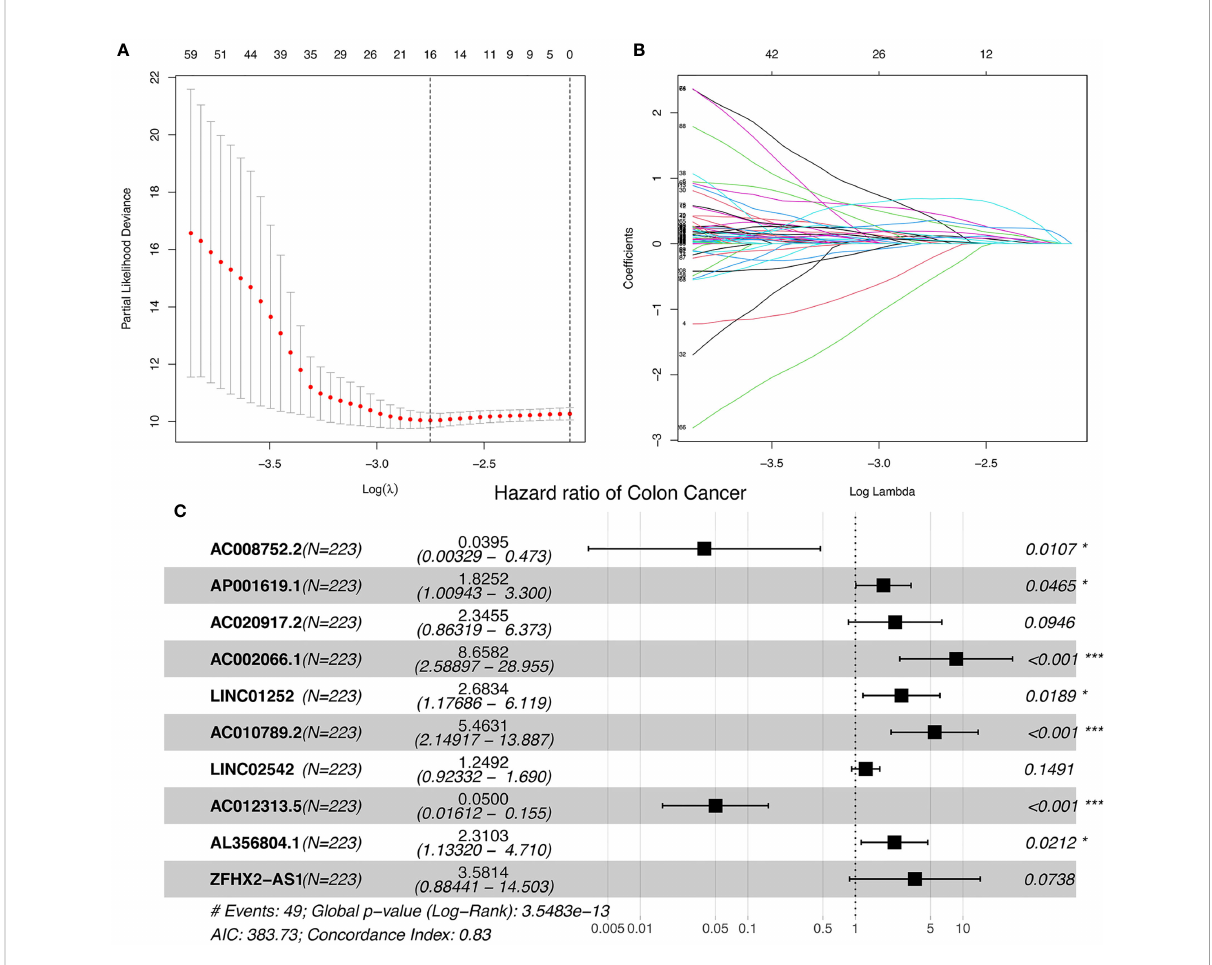
FIGURE 2 Ten cuproptosis-related lncRNAs with prognostic signi fi cance were selected. (A) The con fi dence intervals for each lambda were shown. Dotted vertical lines were drawn at the optimal values by using the minimum criteria. (B) Partial likelihood deviance for different numbers of variables. The horizontal axis represents the log value of the independent variable lambda, and the vertical axis represents the coef fi cient of the independent variable. (C) Multivariate Cox regression analysis showed 10 cuproptosis-related lncRNAs. nsP >= 0.05, *P < 0.05, **P < 0.01, ***P <